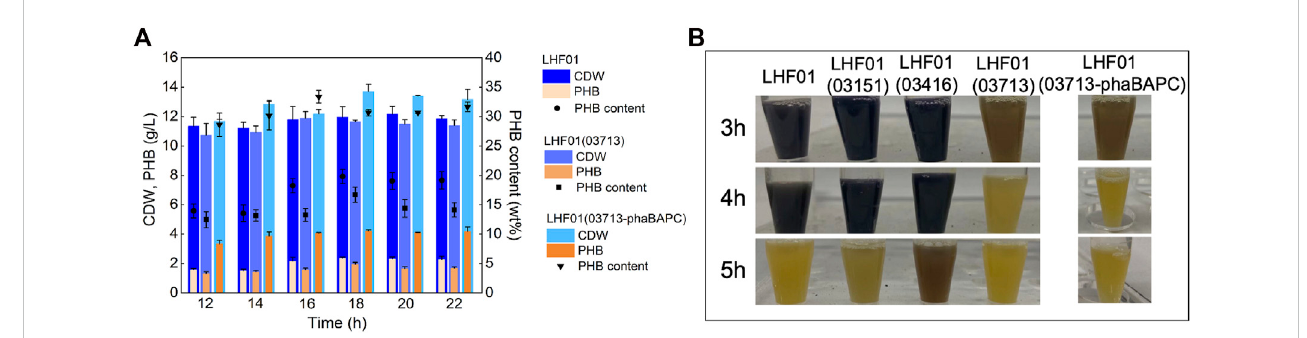
FIGURE 5 Effectsofco-overexpressingamylaseandPHBsynthesisoperononPHBproduction.StrainswerecultivatedinTYS50mediumsupplementedwith20